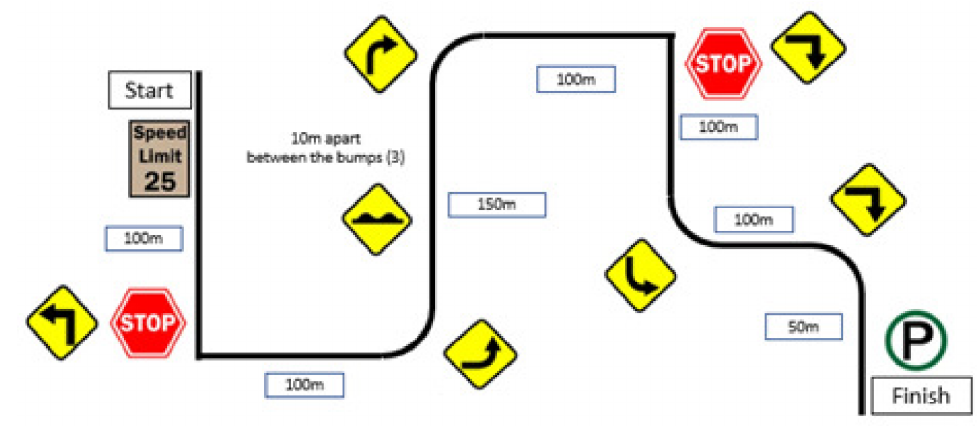
Figure 4. Vehicle riding test course.